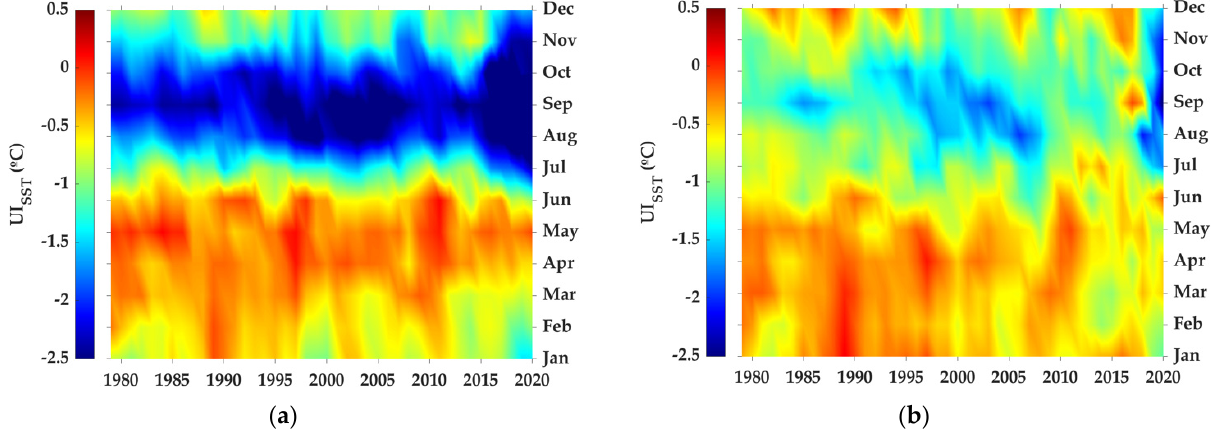
Figure 8. Monthly evolutions of UI SST (°C) from 1979 to 2020: ( a ) west coast and ( b ) south coast.